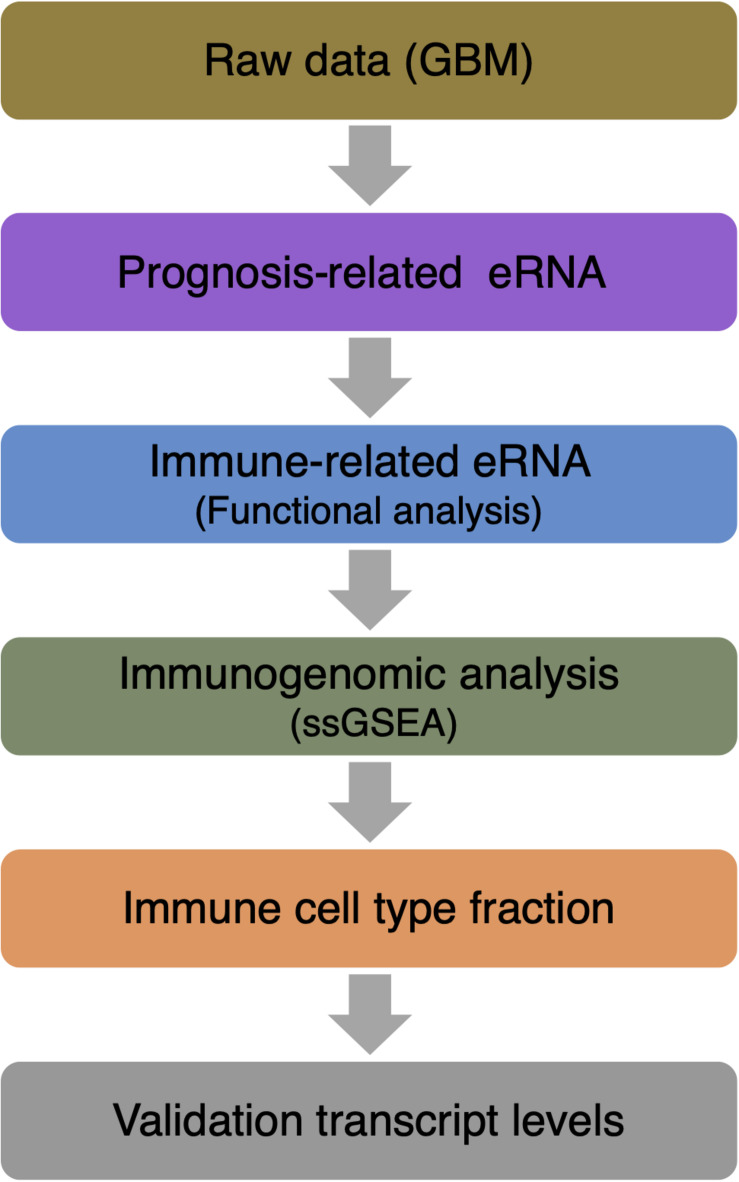
Data analysis workflow.